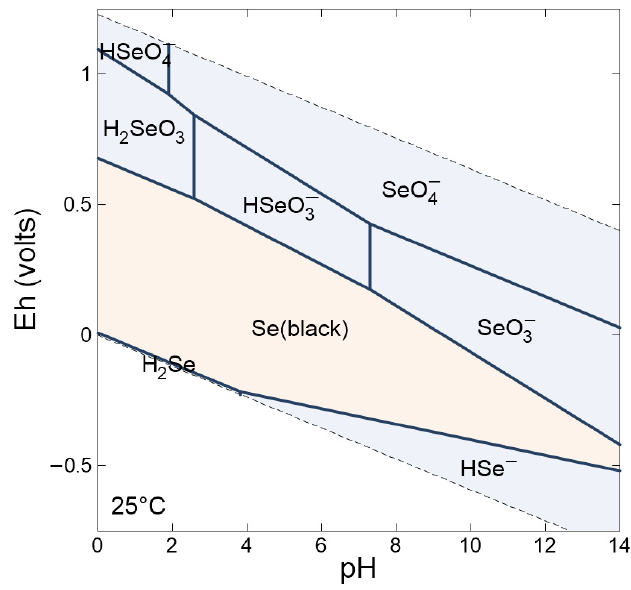
Figure A26. High selenium 5 mg/L, Ca 5 mM (200 mg/L), bicarbonate 7 mM (427 mg/L), sulfate 4 mM (384 mg/L), and chloride 2 mM (71 mg/L).